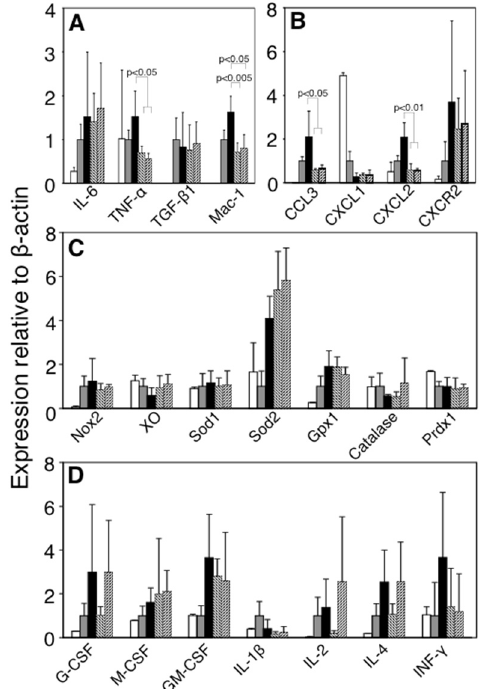
Figure 5. Alteration of inflammation-related gene expressions of inflammatory cells and hematopoietic regulatory factors of bone marrow cells after administration of FBRA. Real-time RT-PCR analysis was performed to quantify the changes in mRNA expressions of cytokines and leukocyte adhesion molecules ( A ); chemokines ( B ) and oxidative stress-related molecules ( C ) in the inflammatory lesions, and interleukins/growth factors ( D ) in the bone marrow cells after administration of basal diet (closed bar), 5% (diagonal right down bar) or 10% FBRA containing diet (diagonal right up bar). For the control, inflammatory cells alone (with implantation of gelatin sponge only, gray bar) and cultured QR-32 cells (open bar) were used. Bar graphs show means ± SD ( n = 4 in each group). Significant differences were observed as compared to those of basal diet group.